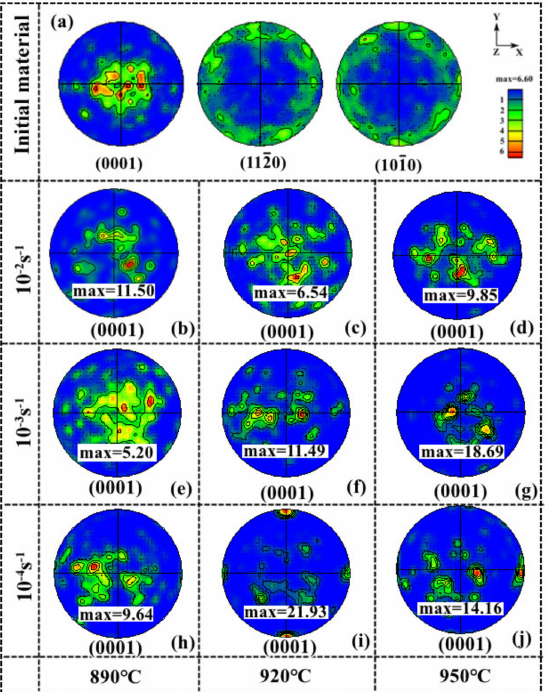
Figure 7. EBSD analysis of pole figure maps (PF) for α -phase for the Ti-6Al-4V alloy. ( a ) Initial material; ( b ) 890 ◦ C, 10 − 2 /s; ( c ) 890 ◦ C, 10 − 3 /s; ( d ) 890 ◦ C, 10 − 4 /s; ( e ) 920 ◦ C, 10 − 2 /s; ( f ) 920 ◦ C, 10 − 3 /s; ( g ) 920 ◦ C, 10 − 4 /s; ( h ) 950 ◦ C, 10 − 2 /s; ( i ) 950 ◦ C, 10 − 3 /s; ( j ) 950 ◦ C, 10 − 4